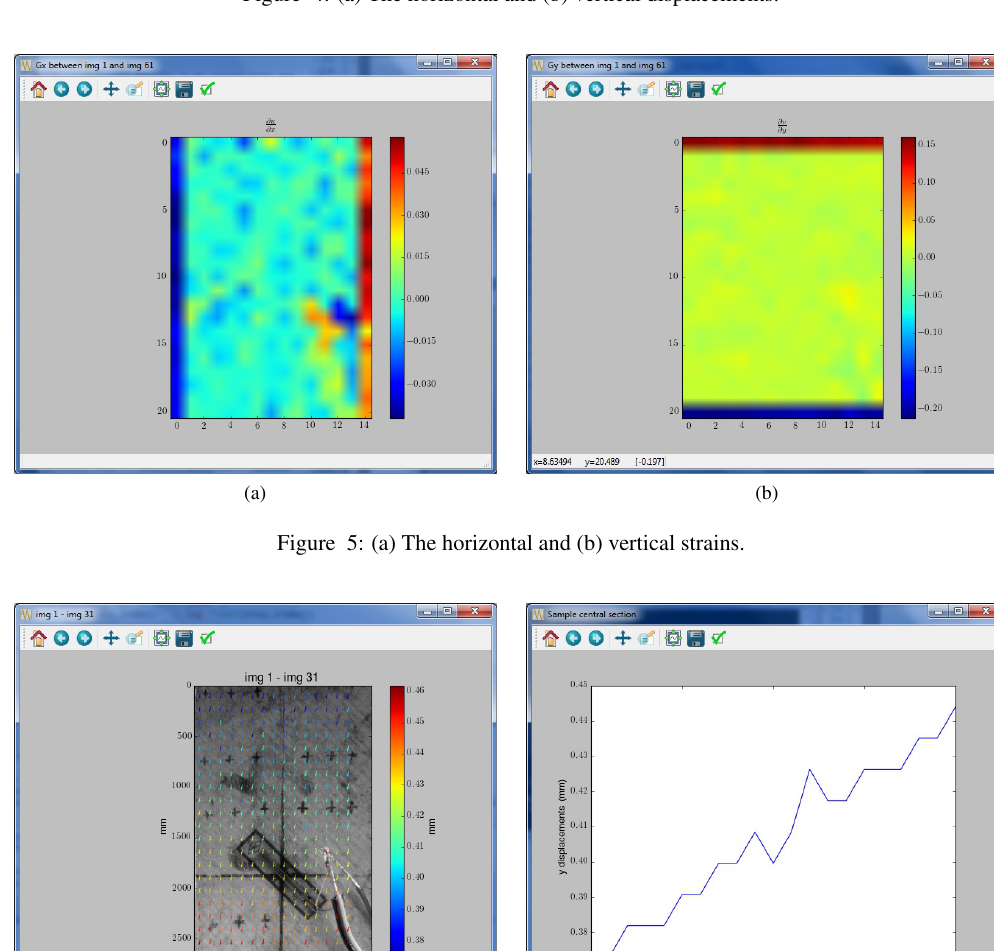
Figure 4: (a) The horizontal and (b) vertical displacements.